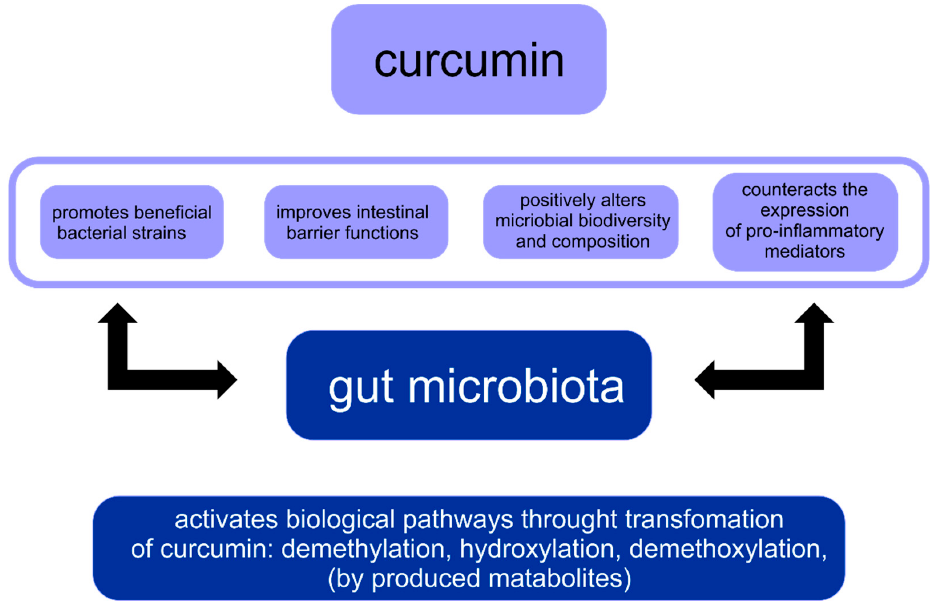
Figure 2. Reciprocal interaction between curcumin and gut microbiota.